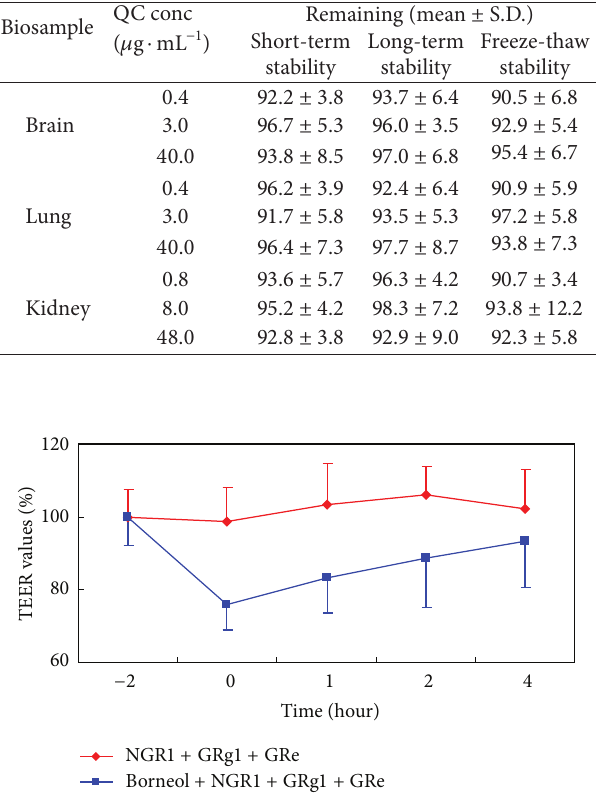
Table 3: Stability of of NGR1, GRg1, and GRe in plasma samples and tissue homogenates of rabbits ( 𝑛 = 6 ).